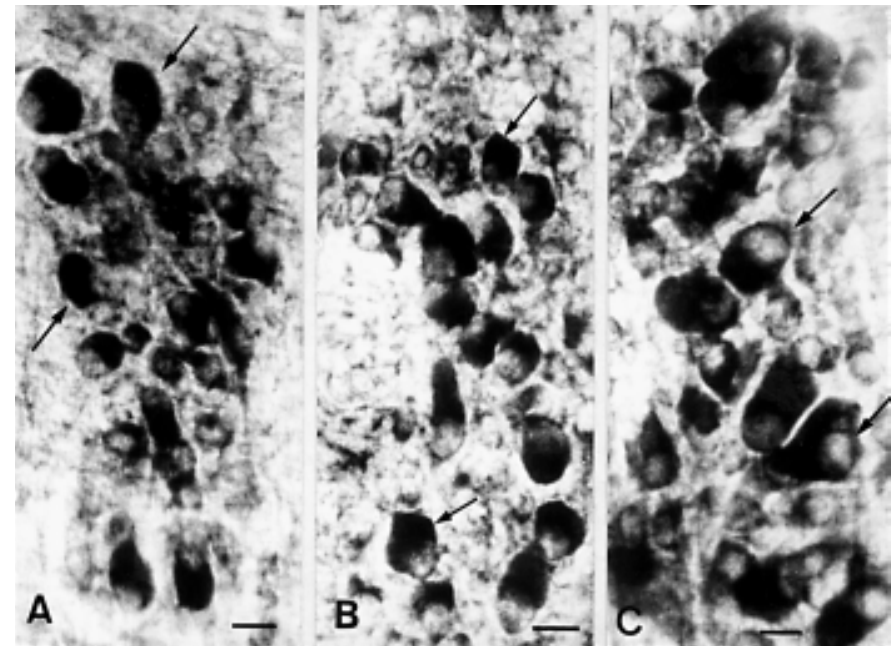
Figure 1 - DPNH-tetrazolium re- ductase-stained myenteric gan- glia of rats on low- and high-so- dium diets. Rats received 0.15 (A) or 8% NaCl in their diets for 15 weeks (B) or 52 weeks (C). Nerve cell bodies (arrows) are intensely stained, except for the nucleus. Magnification bars: A-C = 20